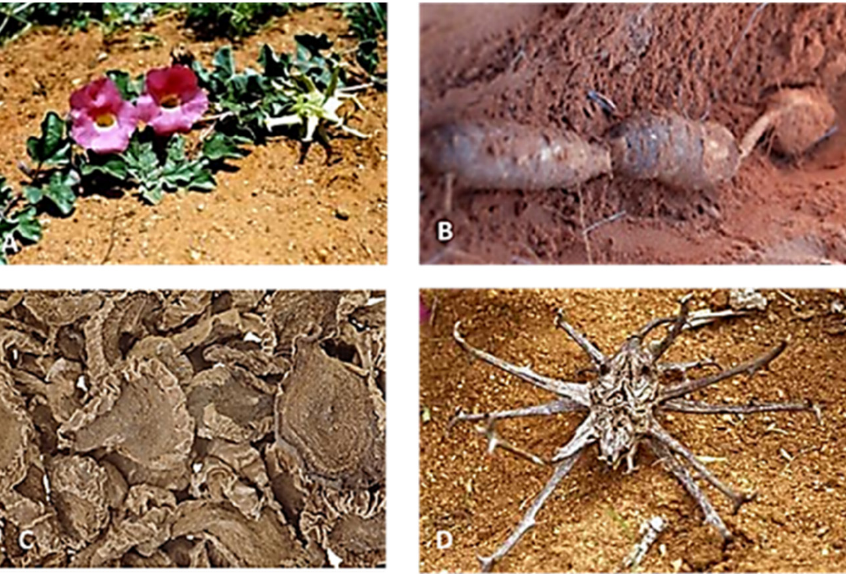
Figure 2. Harpagophytum procumbens (Devil’s Claw) ( A ) Devil’s Claw plant with pink flowers (SANBI) [44]; ( B ) H. procumbens tubers; ( C ) Dried H. procumbens sliced tubers used for plant extracts [27] ( D ) Devil’s Claw (SANBI) [45].